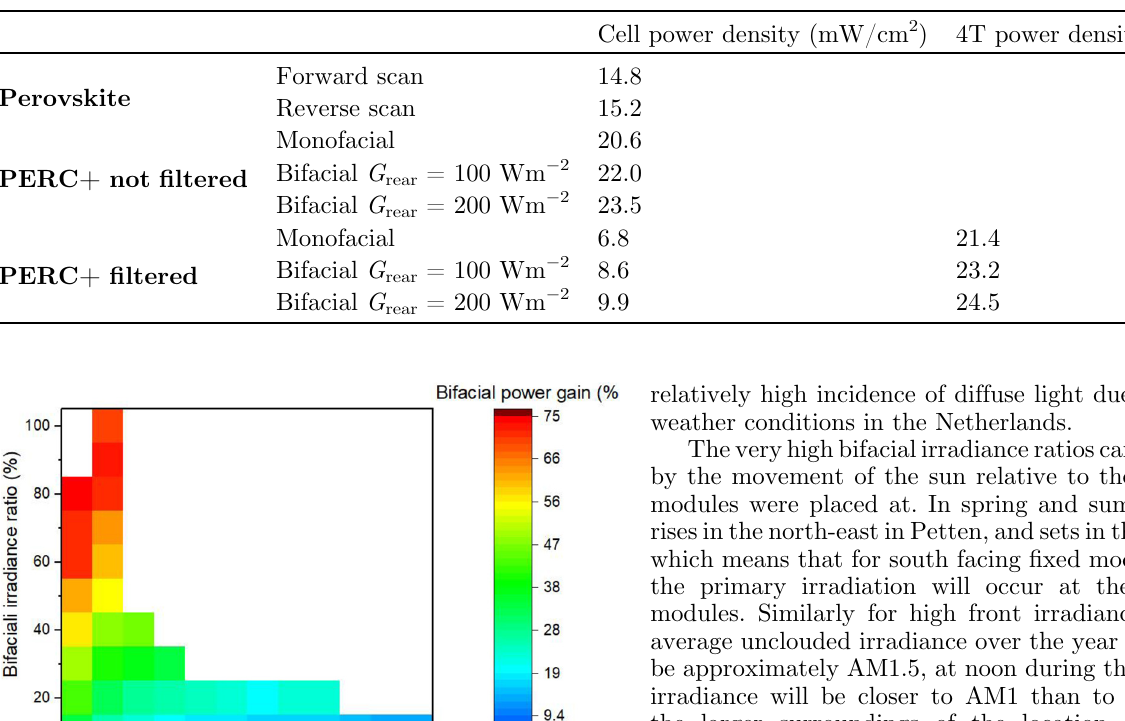
Table 2. Cell and module ef fi ciency of our 4T bifacial tandems with aperture area of 100 cm 2 .